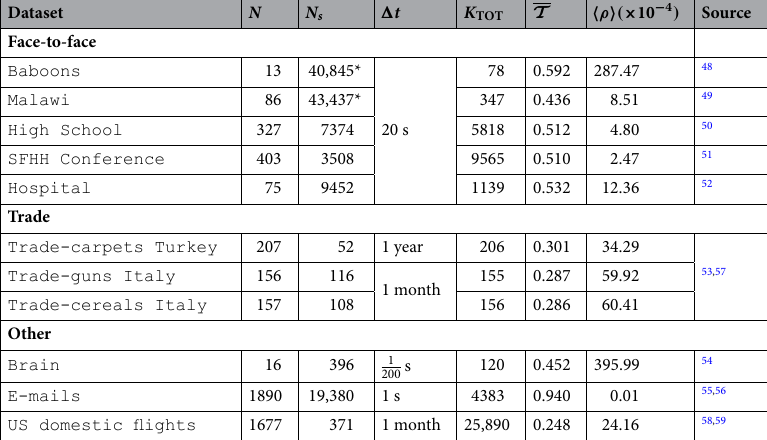
Table 1. Main characteristics of the datasets considered. For each network, we report the number of nodes, N , the number of snapshots N s , the temporal resolution, (cid:31) t , the number of distinct interactions in the aggregated network, K TOT , the average temporality, T , and the edges’ density average over the snapshots’ set, (cid:31) ρ (cid:30) . Finally, we report the data’s bibliographic